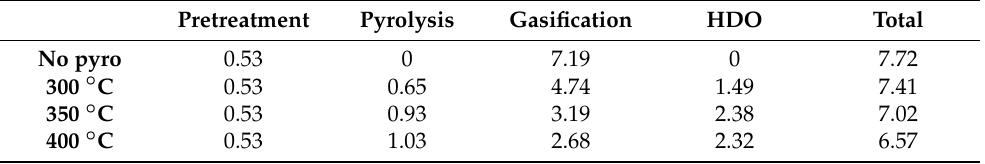
Table 6. Energy input (MJ/kg) at Steam/Biochar optimized and CaO/Char =